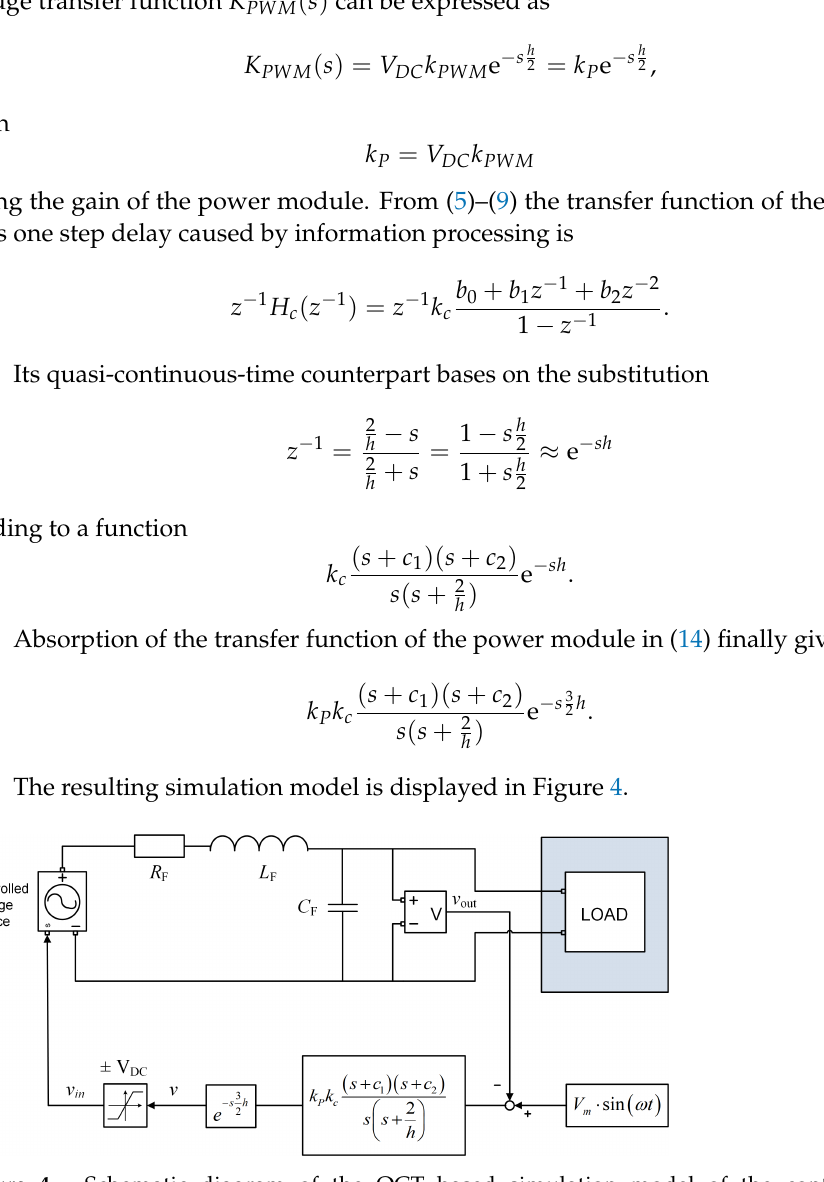
Figure 4. Schematic diagram of the QCT based simulation model of the control system v in = V CD sat { v / V CD }